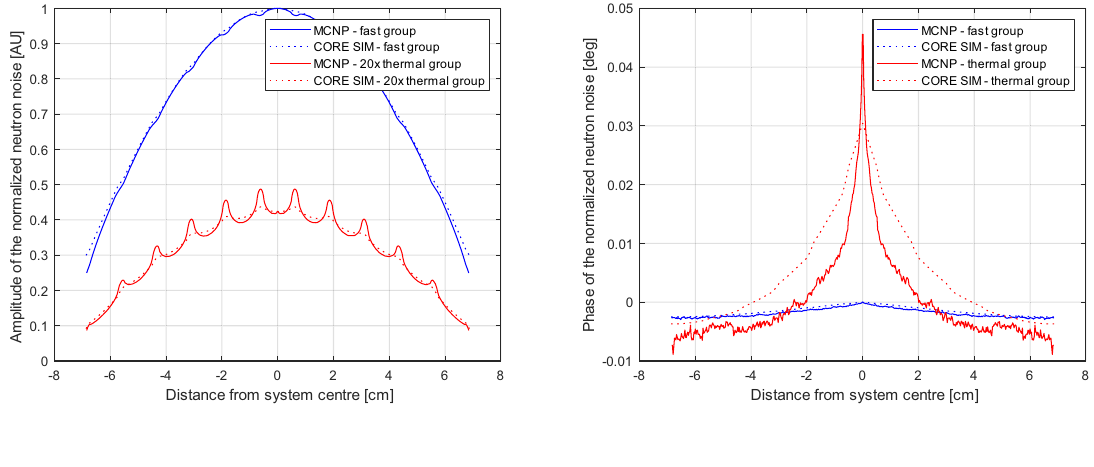
Fig. 4 Results for the heterogeneous test case. All results were normalized to the same induced neutron noise in the fast energy group at the location of the noise